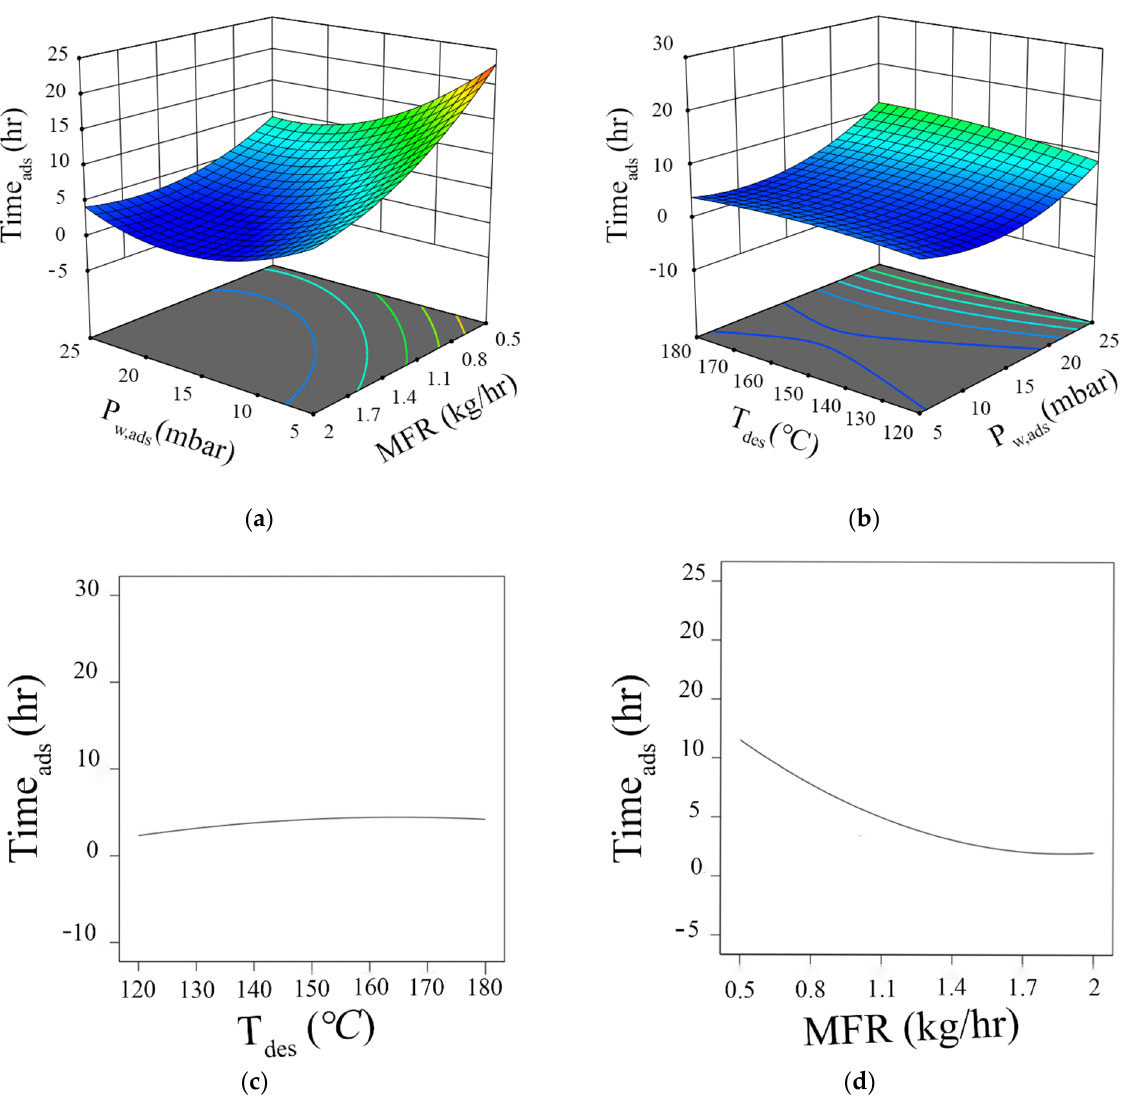
Figure 8. The influence of ( a ) mass flow rate and partial pressure ( b ) desorption temperature and partial pressure ( c ) desorption temperature and ( d ) mass flow rate of incoming air on the discharging time of the reactor .